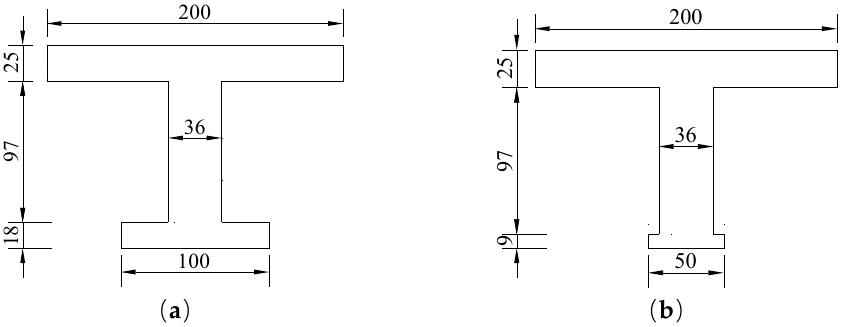
Figure 5. Equivalent sections of the #3-2 girder in undamaged, damaged and repaired states (Unit: cm). ( a ) Undamaged girder and repaired girder; ( b ) Damaged girder.